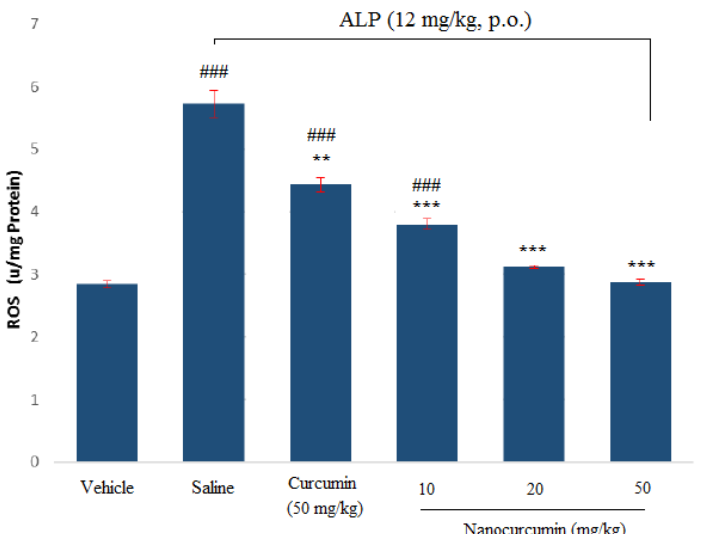
Fig. 2. Effects of curcumin and nanocurcumin on ROS levels in ALP-intoxicated rats. ### P<0.001 significantly different from vehicle. ** P<0.01 and *** P<0.001 significantly different from control group (ALP +saline)